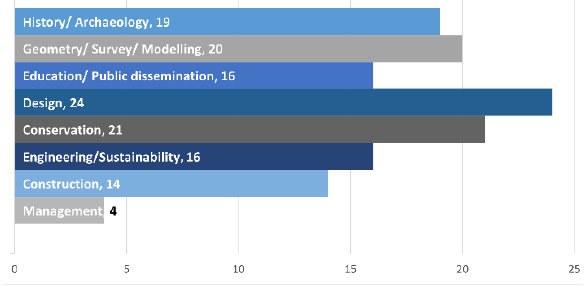
Figure 6: Number of heritage sector participants by interest groups.